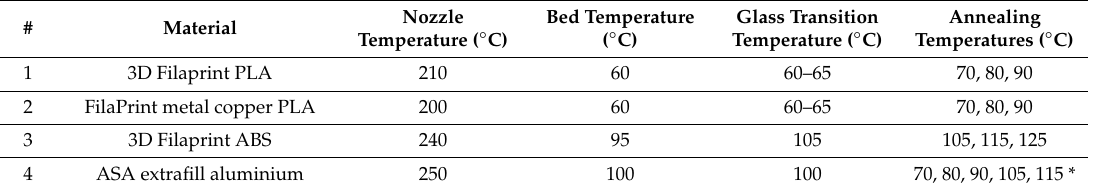
Table 1. Parameters for fused filament fabrication (FFF) build and annealing.